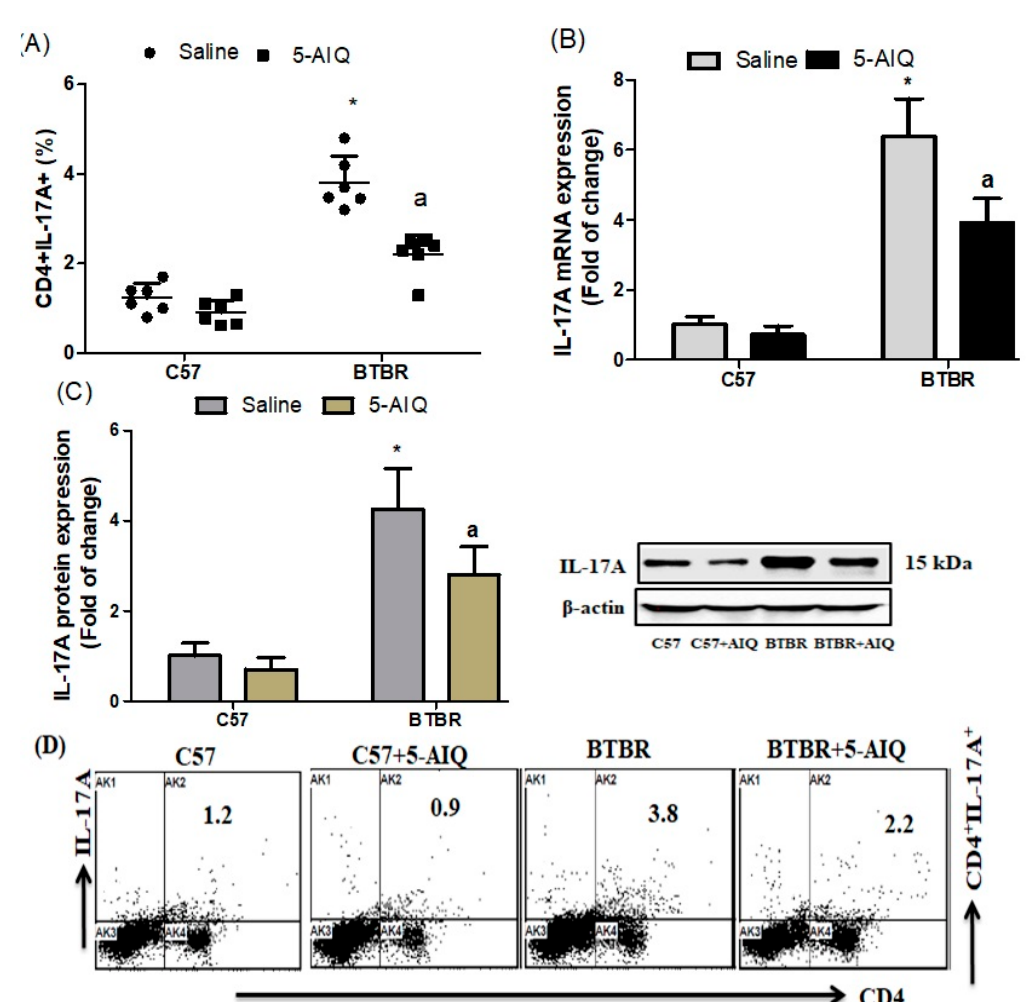
Figure 6. Effects of 5-AIQ on expression of IL-17A in C57 and BTBR mice ( A ) Flow cytometry analysis of intracellular IL-17A-producing CD4+ T cells from mouse spleens (Strain effect, F(1,20) = 120.8, p < 0.0001; Treatment effect, F(1,20) = 30.52, p < 0.0001, Treatment x Strain effect, F(1,20) = 13.54, p < 0.0115); ( B ) RT-qPCR analysis of levels of IL-17A mRNA from mouse brain tissue (Strain effect, F(1,20) = 62.22, p < 0.0001; Treatment effect, F(1,20) = 14.47, p < 0.0011, Treatment x Strain effect, F(1,20) = 7.797, p < 0.0112) and ( C ) Western blotting analysis of levels of IL-17A protein from mouse brain tissue (Strain effect, F(1,20) = 127.8, p < 0.0001; Treatment effect, F(1,20) = 13.8, p < 0.0014, Treatment x Strain effect, F(1,20) = 5.909, p < 0.0246). ( D ) Cells were gated on forward-side scatter dot plots; the dot plots represent the percentages of CD4+IL-17A+ cells. Bar graphs represent the percentage of CD4+IL-17A+ population. The control C57 and BTBR mice received saline intraperitoneal injection. Treated BTBR and C57 mice received 5-AIQ (1.5 mg/kg) via intraperitoneal injection once daily for ten days. The results are shown as the means ± SD, n = 6, each group; * p < 0.05 compared with saline-treated C57 mice; a p < 0.05 compared with saline-treated BTBR mice.